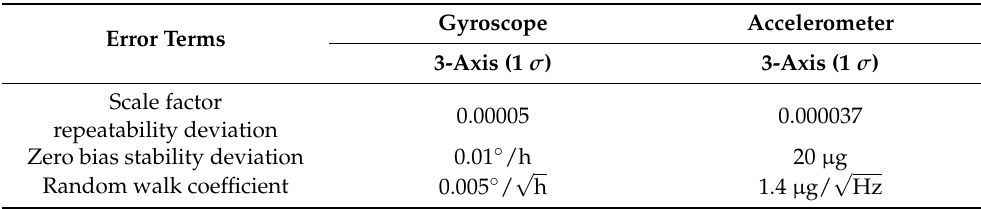
Table 1. Sensor errors settings.